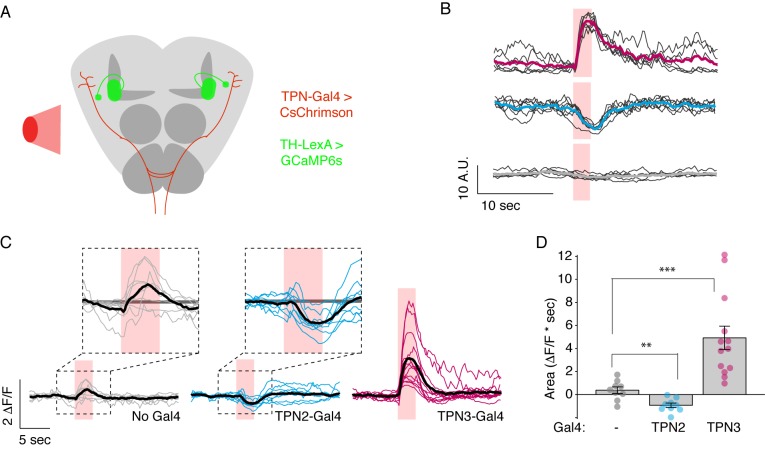
TPNs act upstream of mushroom bodies to influence learned behaviors.(A) Schematic for imaging calcium responses of PPL1-MV1 neurons to CsChrimson activation of TPN2 and TPN3. (B) Example single-animal light-triggered averages of PPL1-MV1 calcium responses to red light activation of TPN3 (top trace), TPN2 (middle trace), and control (bottom trace). Pink background indicates 3 s of red-light stimulation. Individual trails are shown with thin black lines, average trace with thick colored lines. TPN3 activation causes robust increases in PPL1 activity, while TPN2 activation causes a decrease in PPL1 activity. (C) Average PPL1-MV1 calcium responses across multiple animals. Thin colored traces are PPL1-MV1 recordings from individual animals, thick black traces are averages. (D) Average area under the curve. Compared to no Gal4 controls, TPN2 and TPN3 show significant decreases and increases in calcium signal, respectively. Error bars indicate mean ± SEM. n = 9–13. Wilcoxon rank-sum: **p<0.01, ***p<0.001.